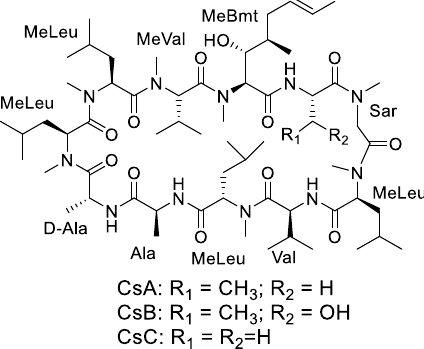
Figure 1. Structures of cyclosporins A – C (CsA – C).